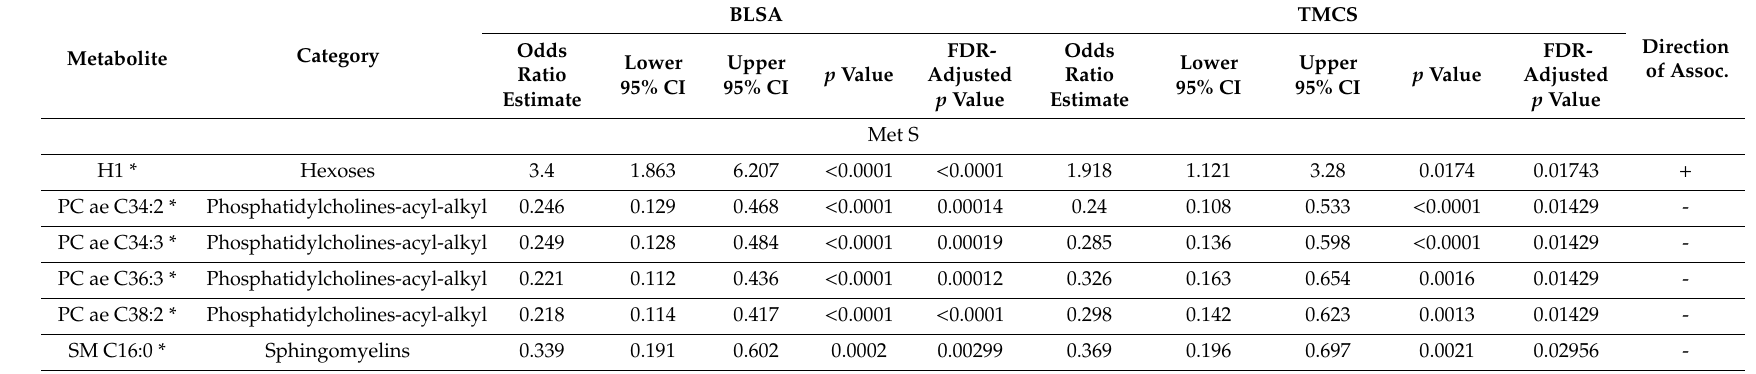
Table 2. Adjusted significant associations in both BLSA and TMCS: